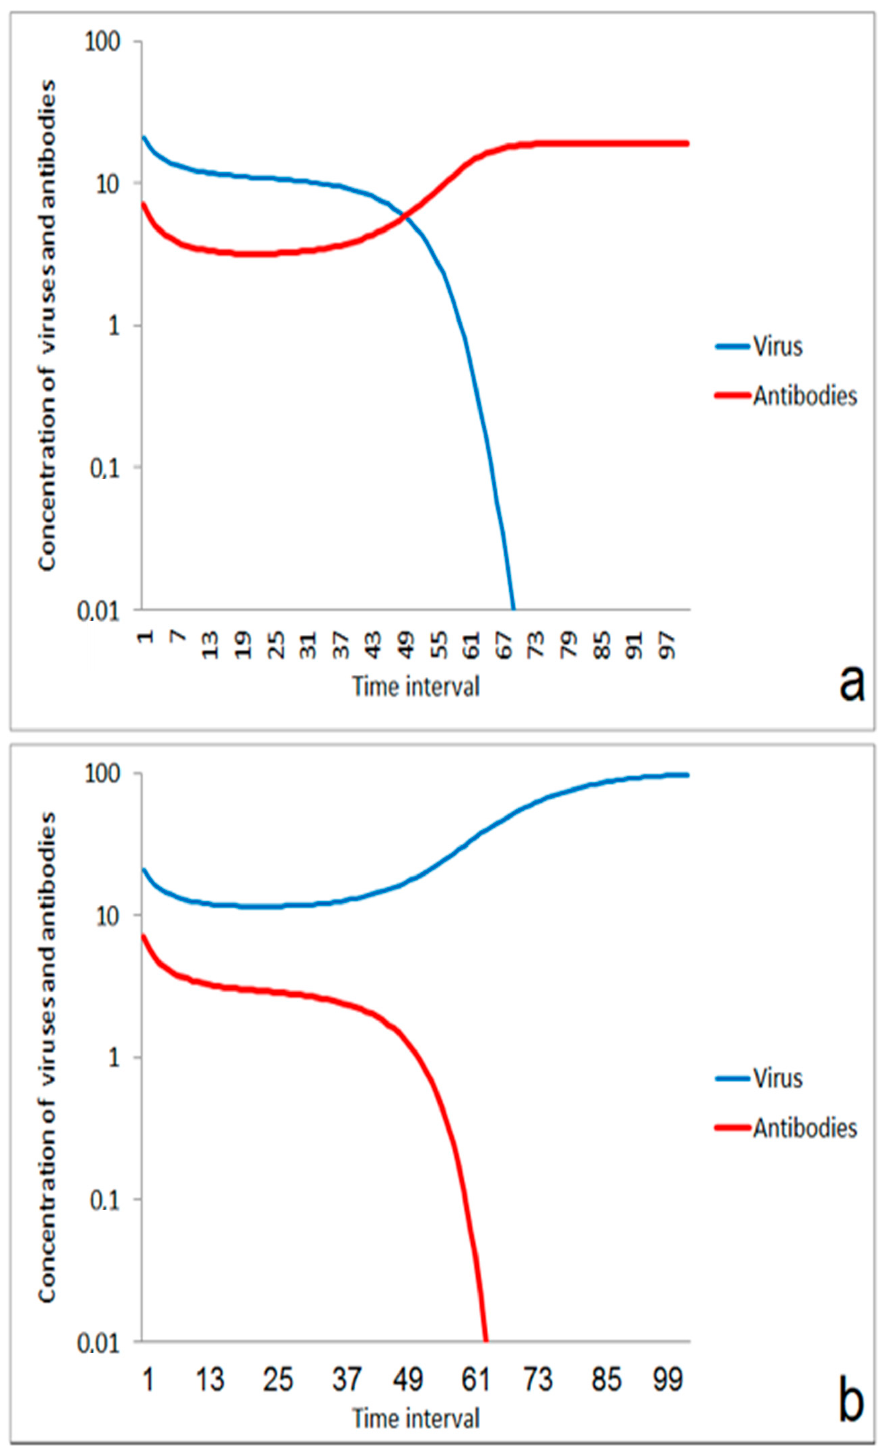
Figure 2. Transient behavior in the competition between virus and immune system in a critical range of start ratio of viruses and antibodies (concentration axis as log scale): ( a ) the transient phase results in a suppression of infection; start conditions: v(0)/a(0) = 20/9; ( b ) The infection propagates after the transient phase; start conditions: v(0)/a(0) = 20/8.